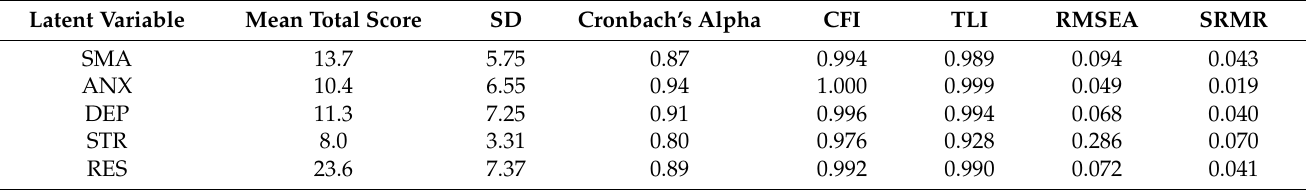
Table 6. Descriptive statistics, reliability and model-fit indices of five latent